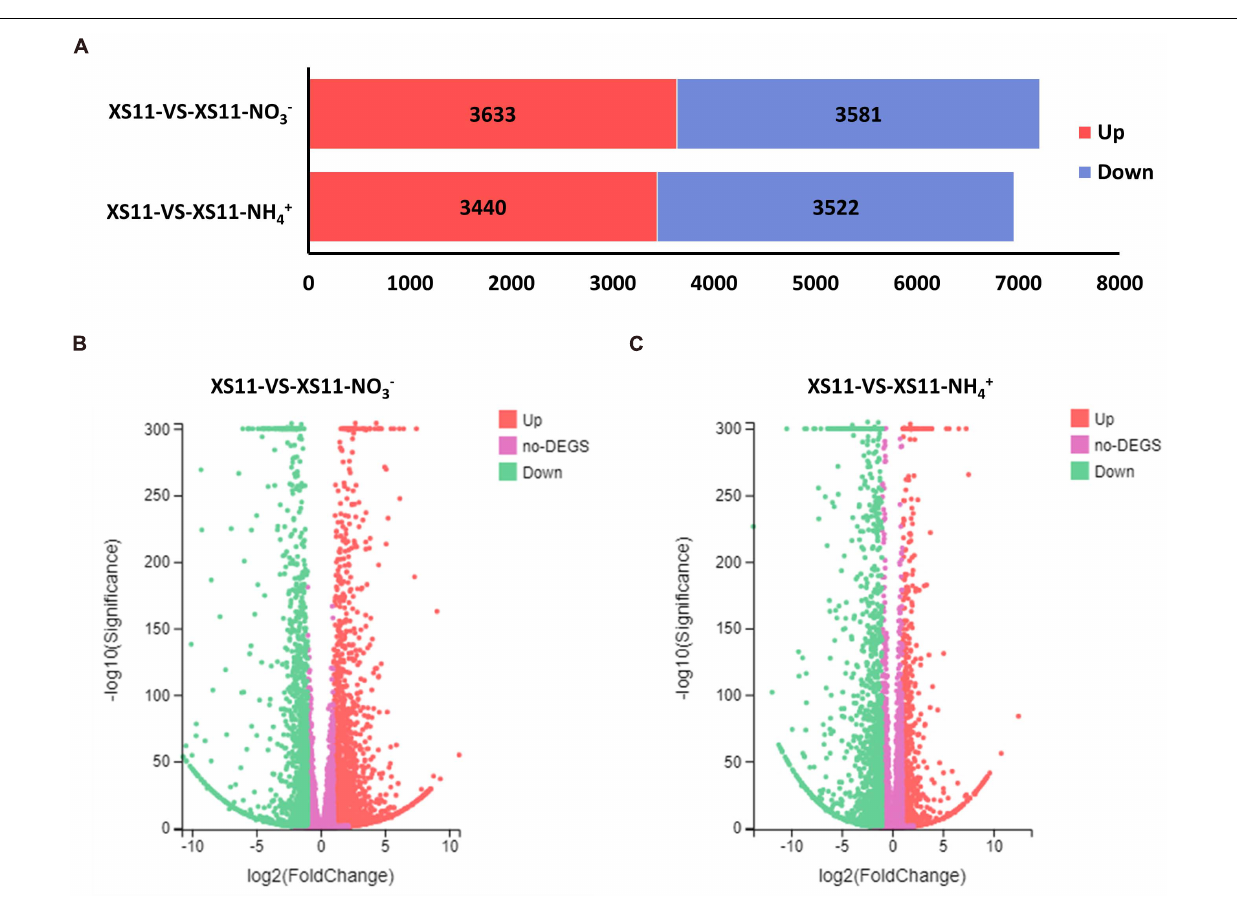
FIGURE 2 | The number of differentially expressed genes (DEGs) in Verticillium dahliae in response to different nitrogen treatments. (A) Bar chart showing a different number of DEGs in the XS11 strain under different treatments in this study. The treatments included 10 mM nitrate (NO 3 − ) or 10 mM ammonium (NH 4 + ) amendments, or control. The red color represents gene upregulation while blue represents downregulation. (B) and (C) . Volcano plot showed the distribution of DEGs at | log2(fold-change) | > 1 and FDR P < 0.05 in the V. dahliae XS11 strain in response to 10 mM nitrate (B) or 10 mM ammonium (C) versus the control. The red point in the plot represents the upregulated DEGs with statistical significance, the green represents downregulated DEGs with statistical significance, and purple indicates DEGs without statistical